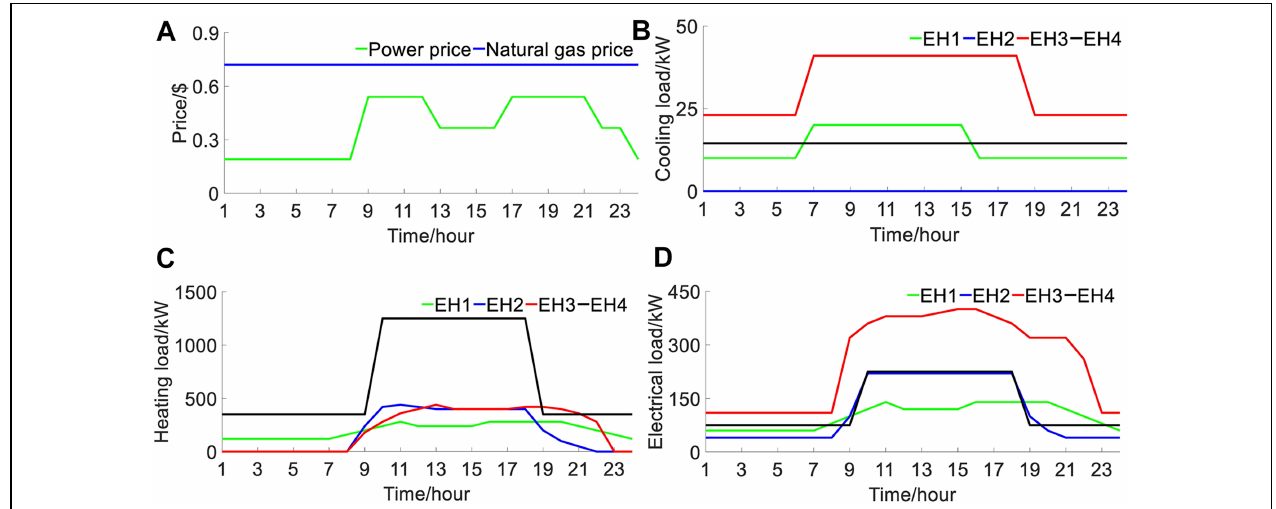
FIGURE 9 | Model data of MRIES. (A) Energy price of system. (B) Daily cooling load of each EH. (C) Daily heat load of each EH. (D) Daily electrical load of each EH.